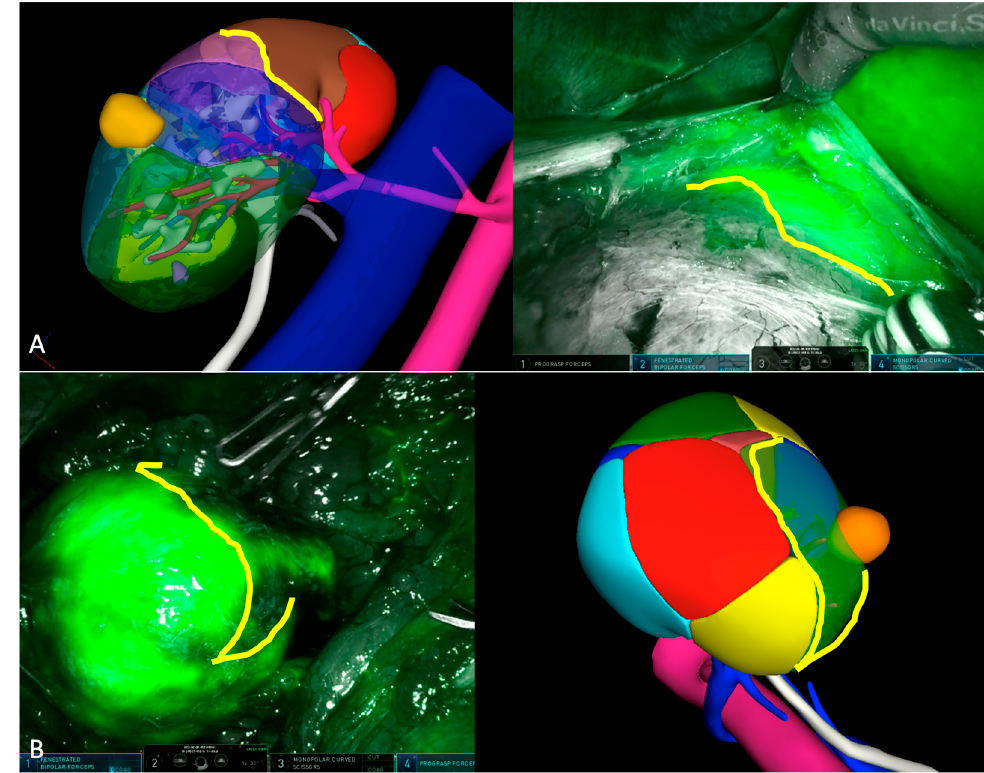
Figure 2. Intraoperative check of selective clamping strategy using near-infrared fluorescence imaging. ( A ) The boundary lines of perfused parenchyma perfectly reproduce the margins of perfusion zones of the 3DVM at the level of the upper pole of the right kidney. ( B ) In this second case, the boundary lines depicted via NIRF show similar orientation with those of the 3DVM.